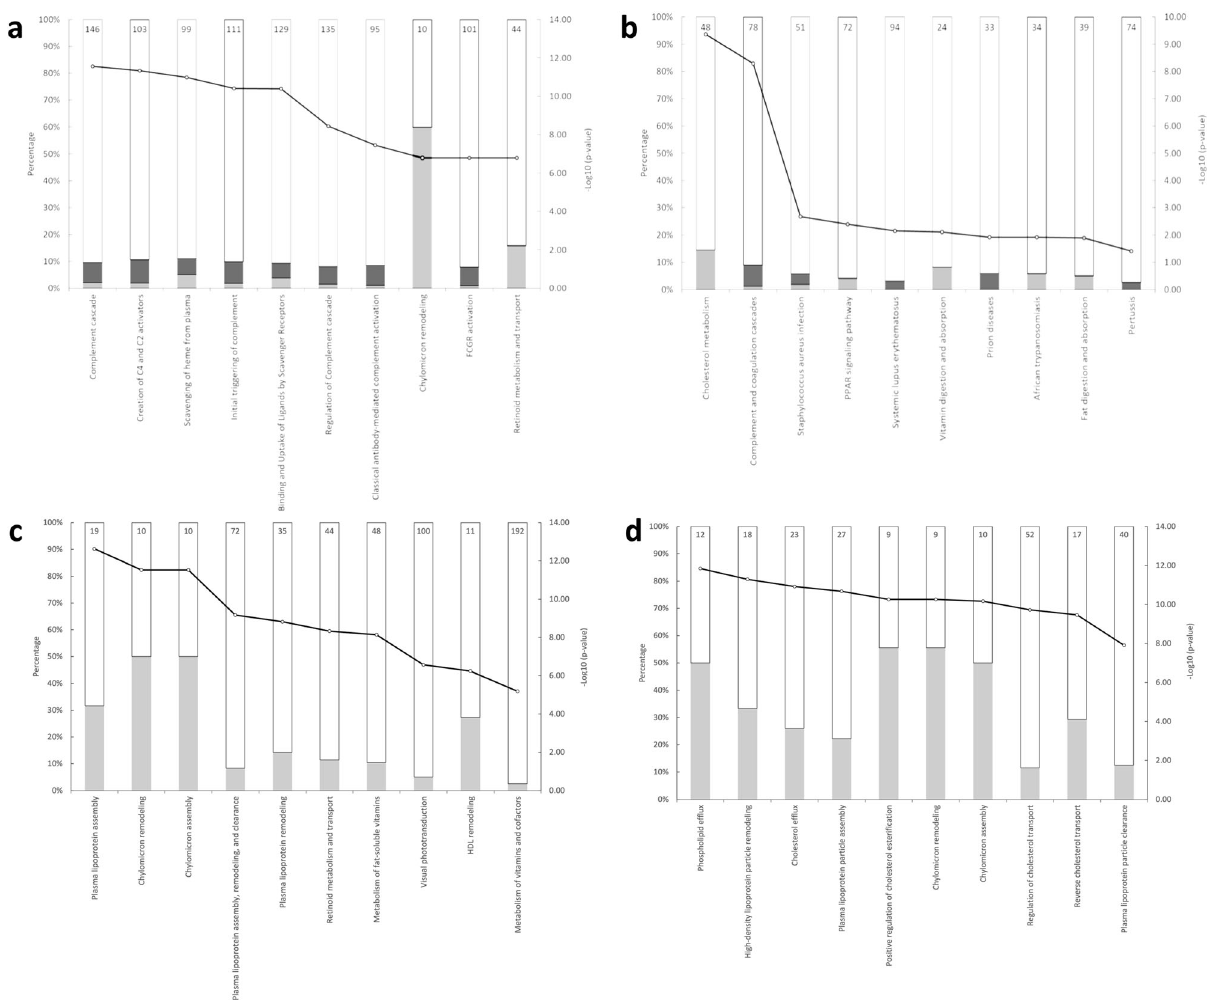
Fig. 3 Enriched pathways between COVID-19 ARDS and Healthy Group. Top 10 enriched pathways for the 52 differentially expressed proteins based on the unadjusted p value and fold-change comparison between COVID-19 ARDS Group and Healthy Group, ranked in increasing order of their p values (determined using two-sided t test) from left-to-right. ( a Reactome pathway analysis; b STRING pathway analysis). Top 10 enriched pathways for the 17 differentially expressed proteins based on the adjusted p value (using two-sided t test adjusted for multiple comparison with Benjamini-Hochberg correction) comparison between COVID-19 ARDS Group and Healthy Group, ranked in increasing order of their p values from left-to-right. ( c Reactome pathway analysis; d STRING pathway analysis). The size of the bar in each graph indicates the proportion of proteins in that pathway that are up- or down- regulated in our study, the number reported at the top of each bar is the speci fi c number of proteins in that pathway affected. Dark grey: proteins with relative increased expression in COVID-19 ARDS Group; Light grey: proteins with relative decreased expression in COVID-19 ARDS Group. Black line with a white circle: -Log10 ( p value). Indicated pathways suggest biological pathways that are most impacted as a result of COVID-19